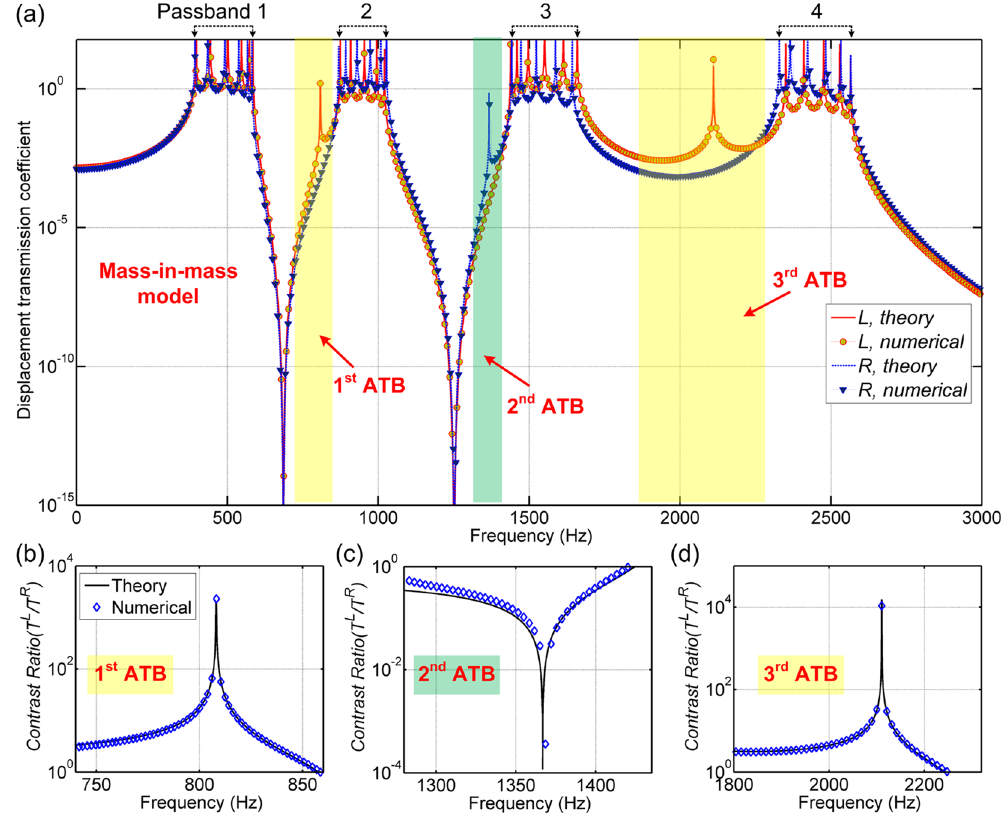
Figure 2. ( a ) Transmission coefficient-frequency profiles obtained by theoretical analysis and FEA. The profiles of asymmetric contrast ratio obtained in the ( b ) 1 st , ( c ) 2 nd and ( d ) 3 rd ATBs in the mass-in-mass